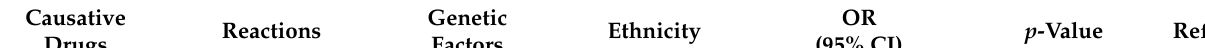
Table 2. Genetic variants associated with antiepileptics-induced hypersensitivity